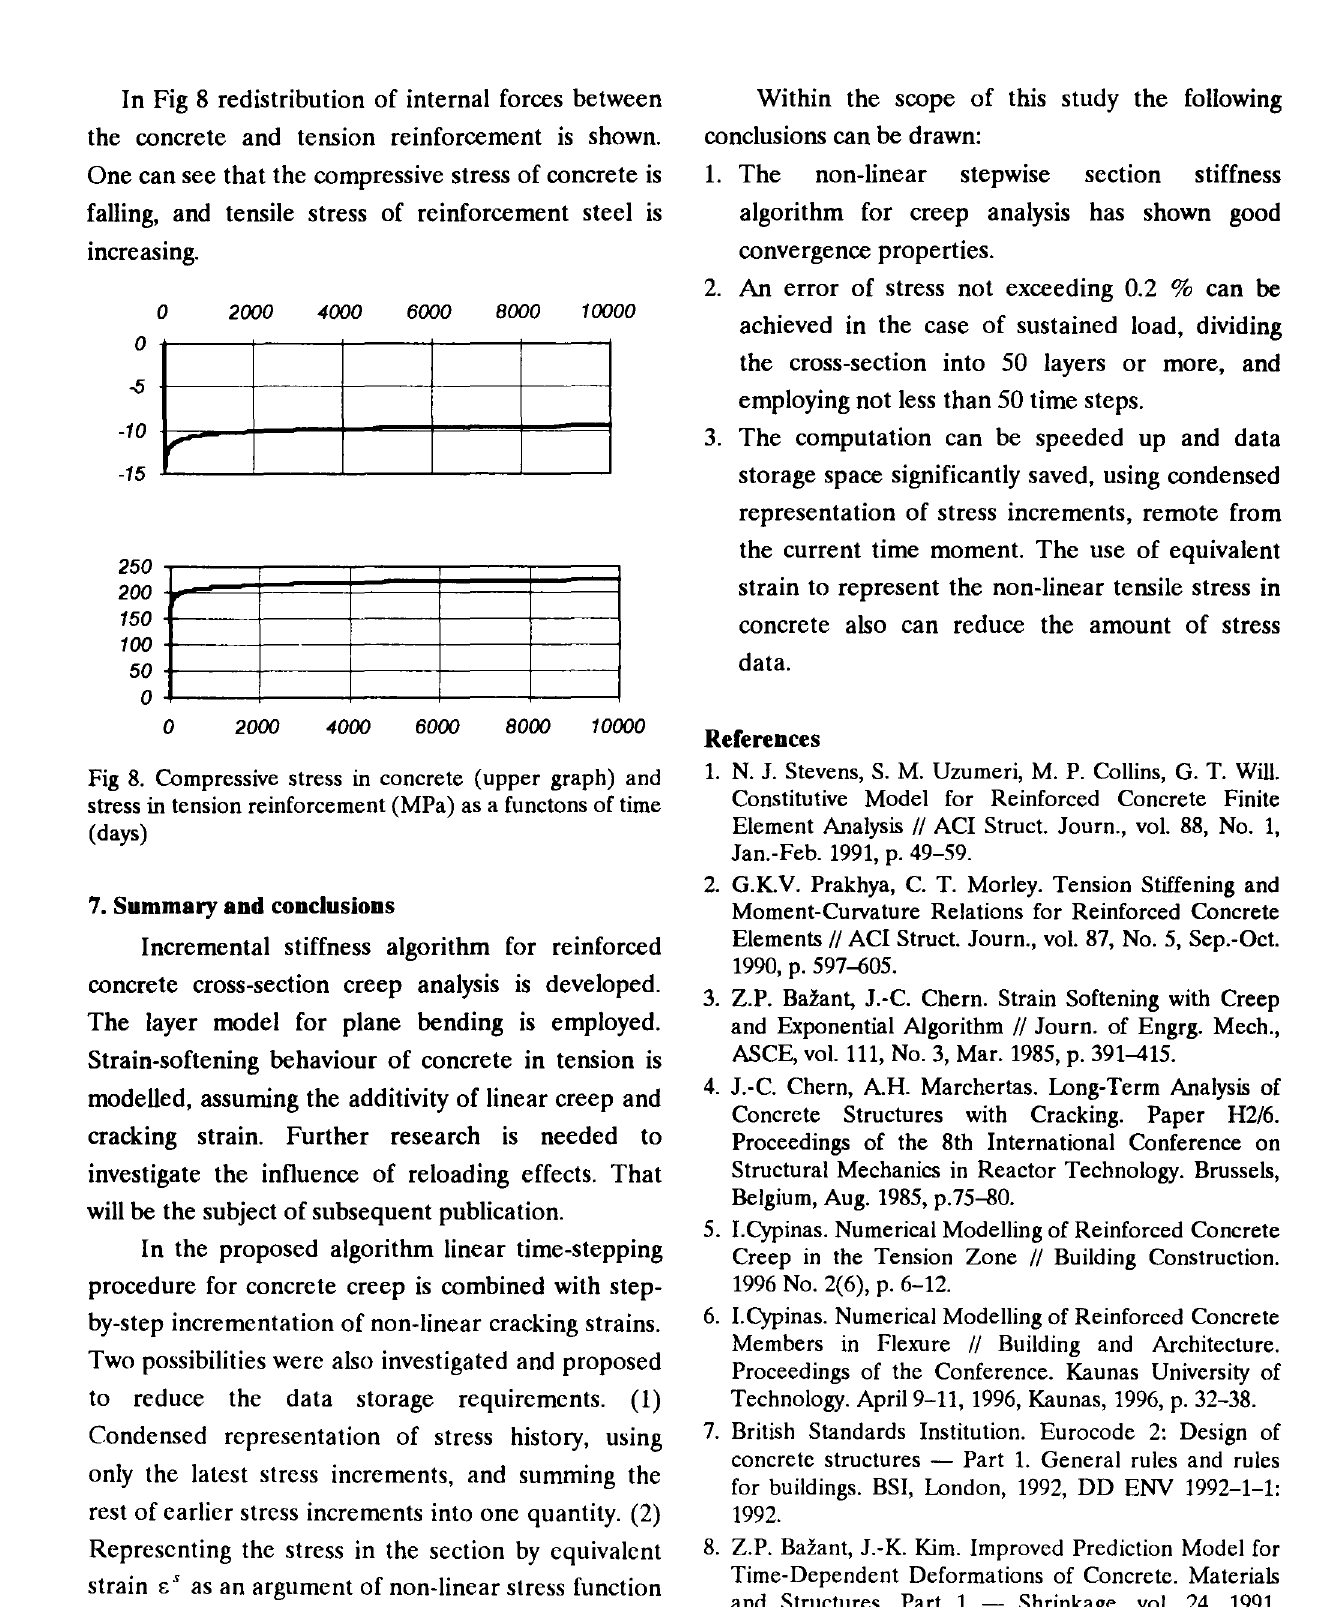
Fig 8. Compressive stress in concrete (upper graph) and stress in tension reinforcement (MPa) as a functons of time